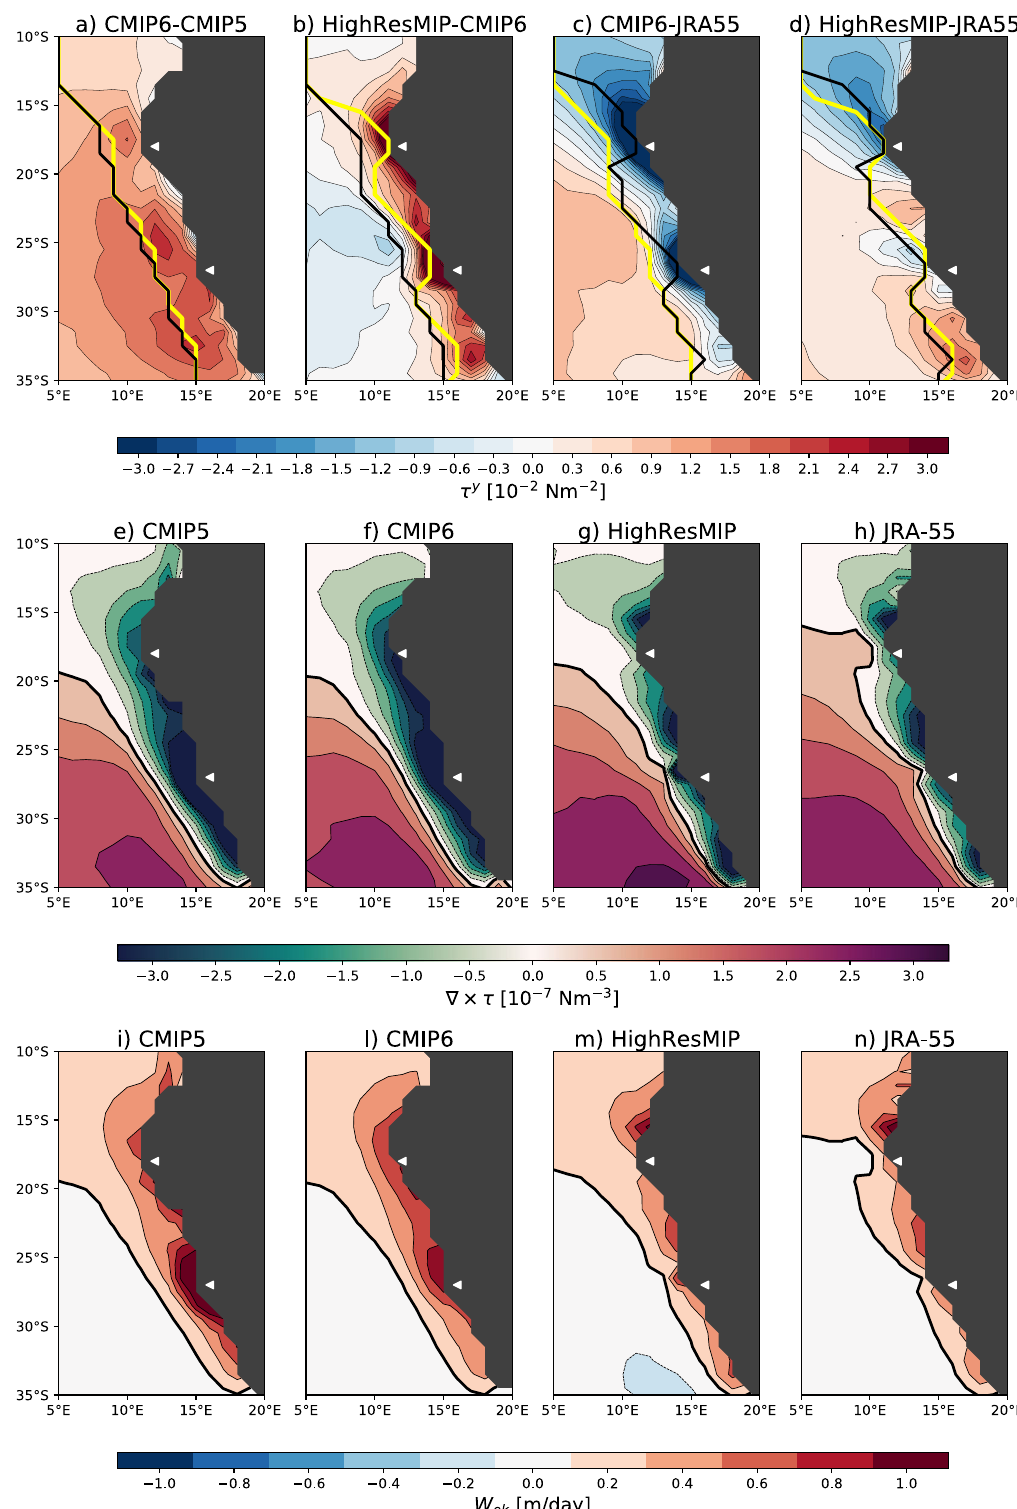
Fig. 3 Meridional wind stress differences, wind stress curl and Ekman pumping. (top row) Difference between the MMMs meridional wind stress ( a ) CMIP6-CMIP5, ( b ) HighResMIP-CMIP6, ( c ) CMIP6-JRA55 and ( d ) HighResMIP-JRA55. In every panel, the yellow line marks the position of the maximum τ y for the fi rst MMM and the black line the same position for the second MMM. Contour interval is 0.3 × 10 − 2 Nm − 2 . (middle row) Time-mean wind stress curl in ( e ) CMIP5, ( f ) CMIP6, ( g ) HighResMIP MMMs and ( h ) JRA-55. (bottom row) Time-mean Ekman pumping ( W ek = ∇ × τ /( ρ 0 f ), in m/day) in ( i ) CMIP5, ( l ) CMIP6, ( m ) HighResMIP MMMs and ( n ) JRA-55. Positive values indicate upward velocities. The white triangles by the coast show the location of Cape Frio (17 ∘ S – 18 ∘ S) and L € u deritz (26 ∘ S – 27 ∘